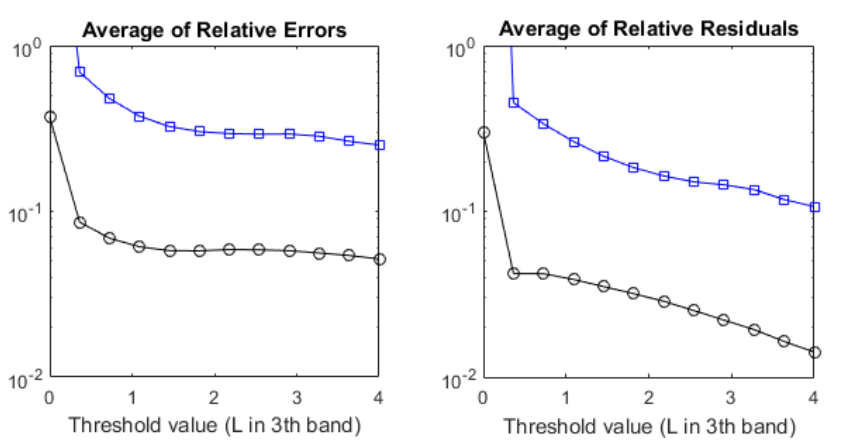
Figure 12. Evolution of the discrepancies between hyperspectral and multispectral temperatures (black circles) and column densities (blue squares) for a Bunsen flame, measured as average relative error ( left ) and average residuals ( right ), as a function of the radiance threshold, measured in W/m 2 · sr · cm − 1